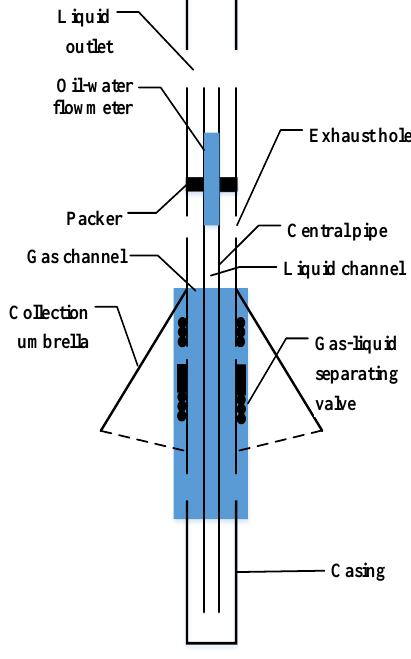
Figure 2. DGLS profile diagram.